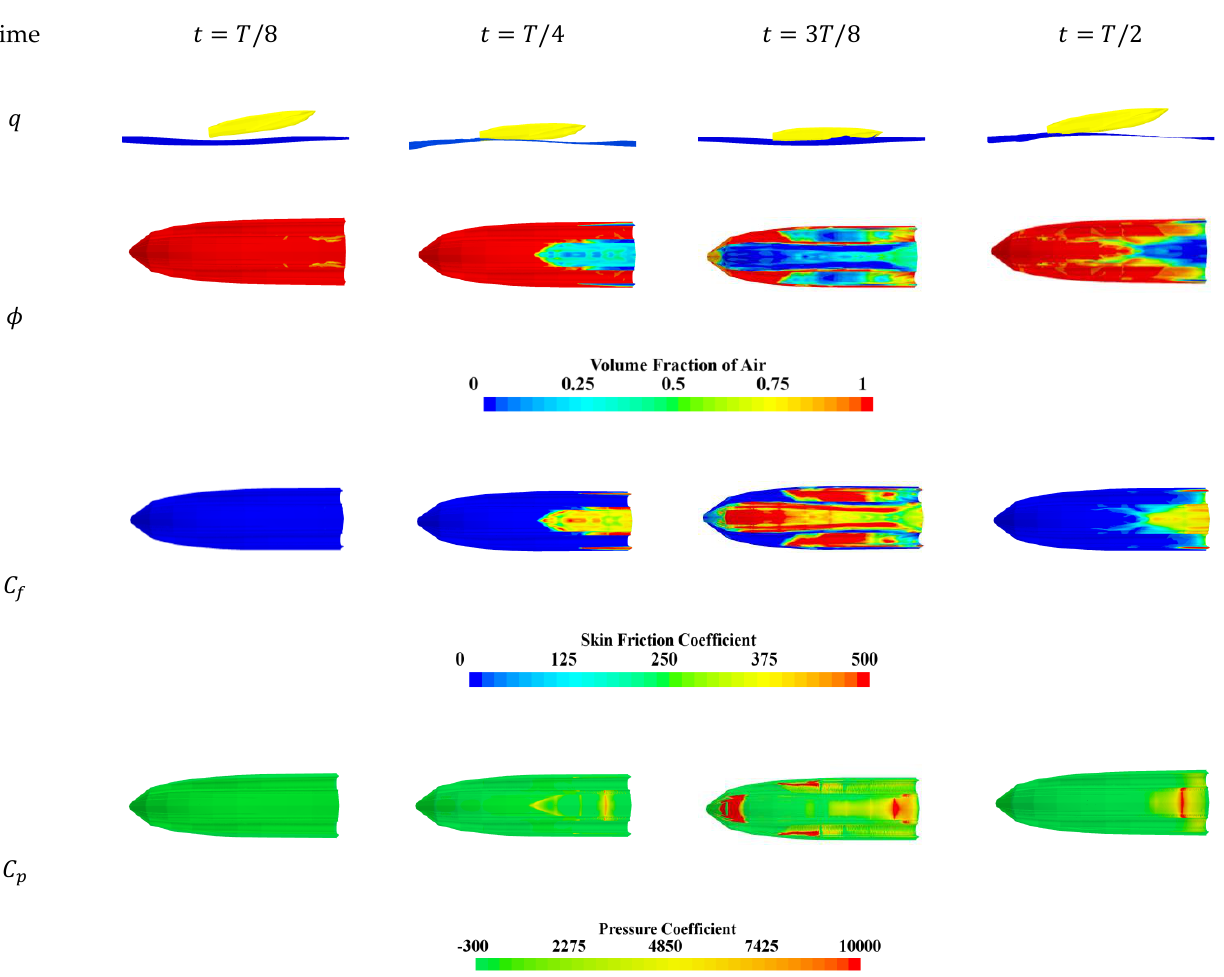
Figure 16. As in Figure 13, but for a beam Froude number of 5.6.